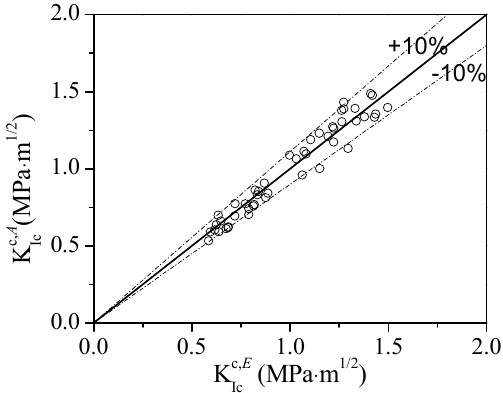
c K . Figure 6. Comparison between analytical and experimental K c Ic Ic